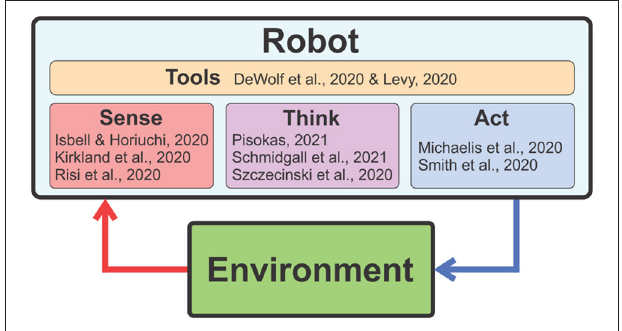
FIGURE 1 | The articles of this Research Topic are organized into the following four themes: Sense, Think, Act, and